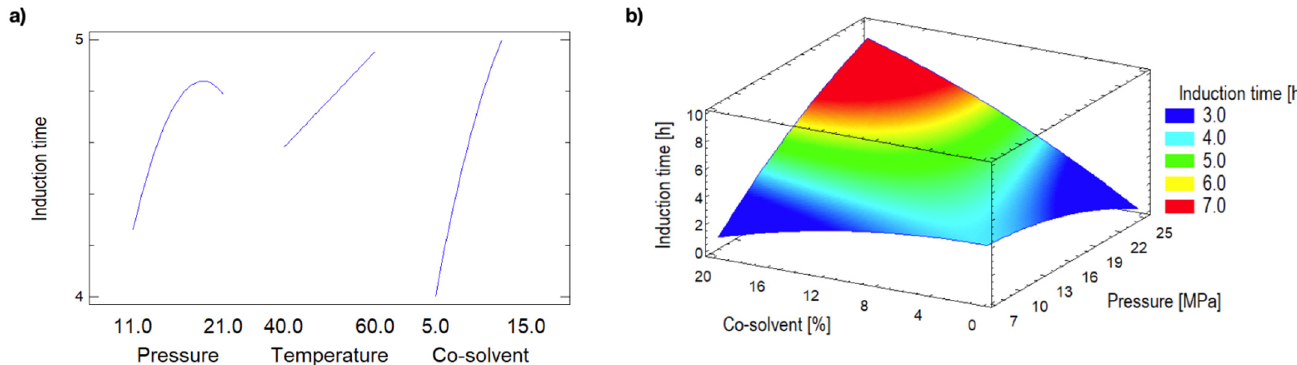
Figure 3. Main effects ( a ) and response surface predicted for the induction time of sunflower oil added with extracts obtained by supercritical fluid extraction at 67.0 °C ( b ).